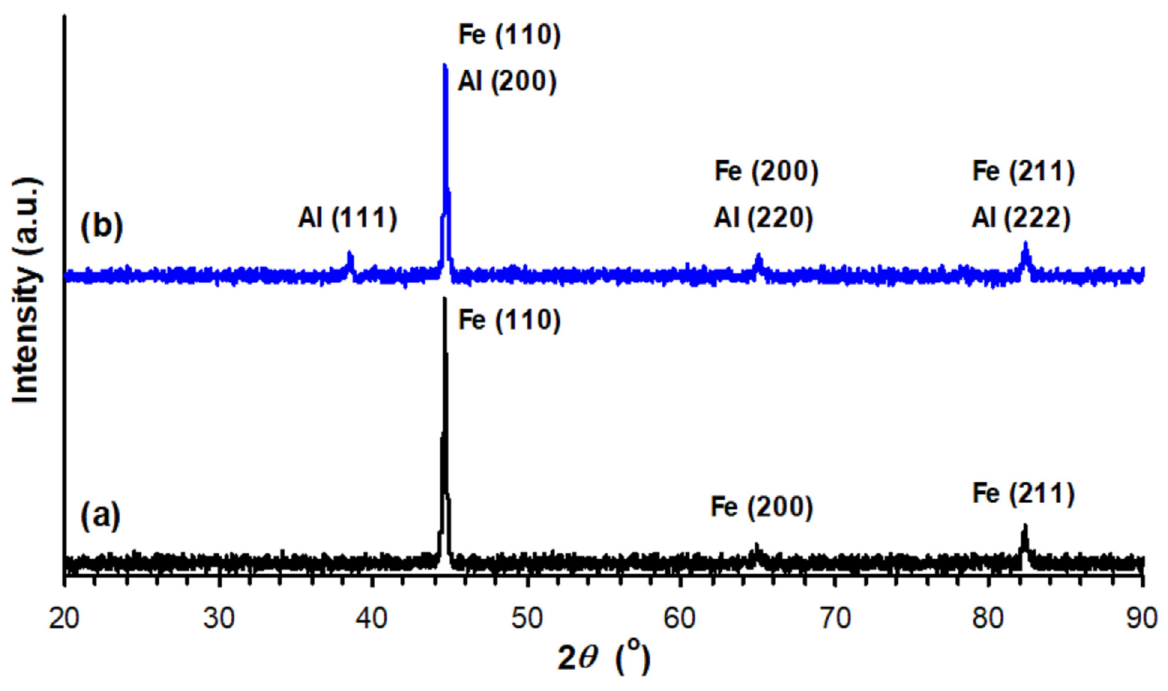
Figure 4. XRD patterns of (a) substrate and (b) first step coating of the